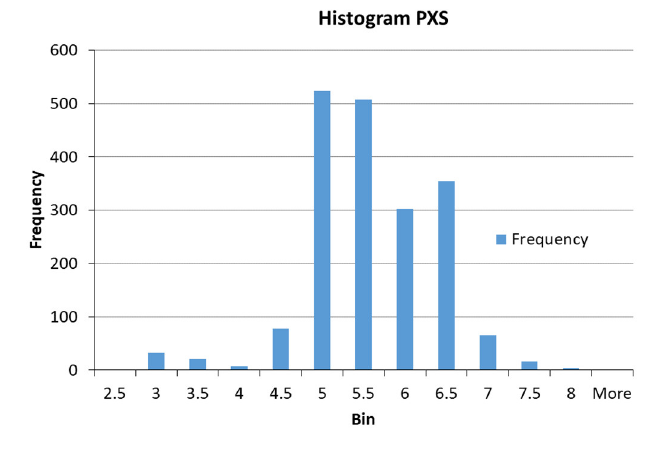
Figure A10. Collector consumption in scavenger flotation stage (PXS)—dataset distribution.